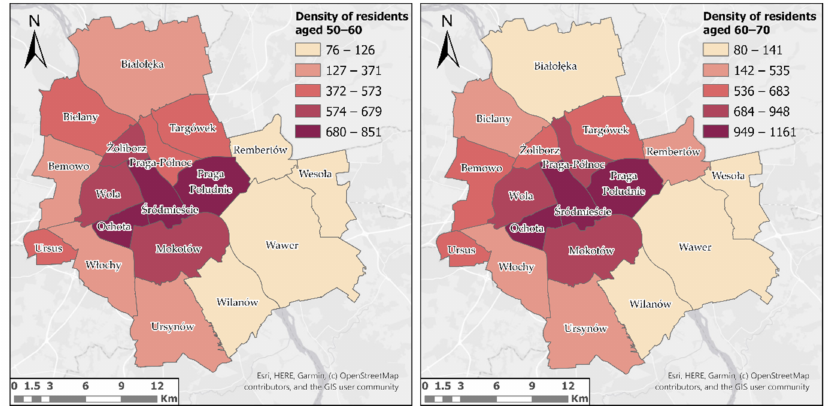
Figure 7. The results of the analysis of the density of the older population by Warsaw